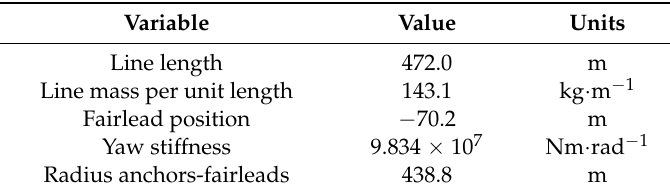
Table 2. Main characteristics of the mooring